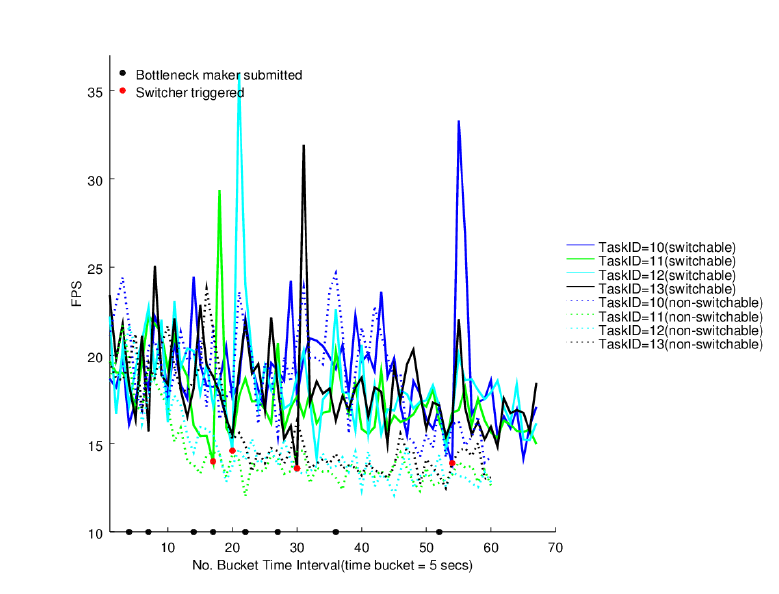
Figure 13. Switcher performance under the I/O-intensive bottleneck